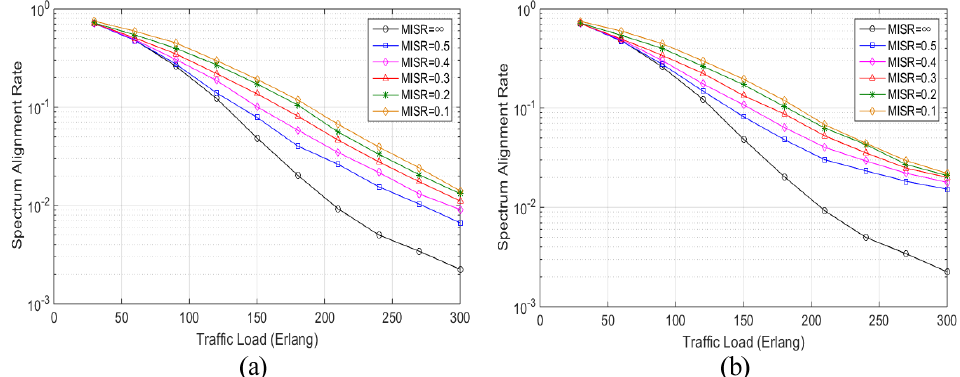
Figure 4. Simulation results of the spectrum alignment rate. ( a ) Simulation results of the spectrum alignment rate vs. the traffic load with different values of MISR when no spectrum defragmentation is adopted, ( b ) simulation results of the spectrum alignment rate vs. the traffic load with different values of MISR when spectrum defragmentation is adopted.